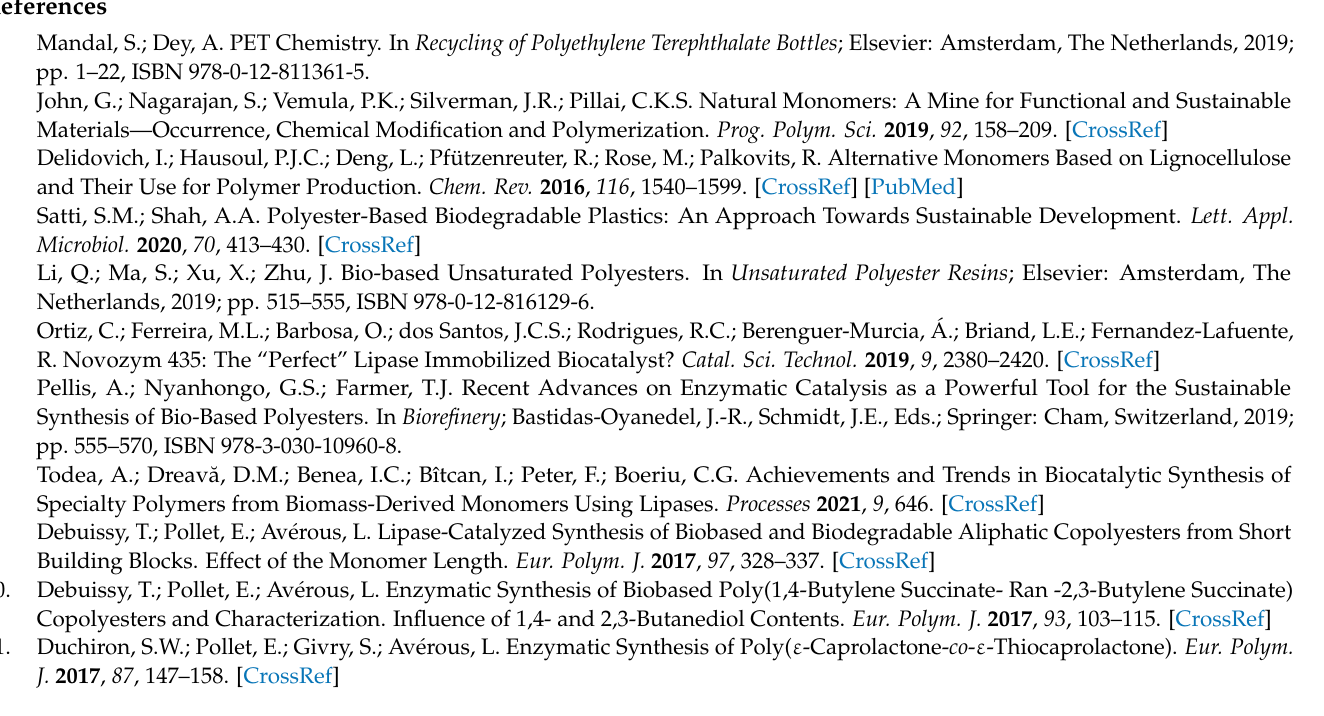
( 2b ) in CDCl 3 ; Figure S16. HSQC NMR analysis of methyl 4-(methyl butanoate-oxy)-ferulate ( 2b ) in CDCl 3 ; Figure S17. 1 H NMR analysis of poly(butylene-co-4-(methyl ethanoate-oxy)-ferulate) ( 3a ); Figure S18. 1 H NMR analysis of poly(butylene-co-4-(methyl butanoate-oxy)-ferulate) ( 3b ); Figure S19. 1 H NMR analysis of poly(butylene-co-3-(3-methoxy-4-(2-methoxy-2-oxoethoxy)phenyl) propanoate) ( 5a ); Figure S20. 1 H NMR analysis of poly(butylene-co-4-(2-methoxy-4-(3-methoxy- 3-oxopropyl)phenoxy) butanoate) ( 5b ); Figure S21. 1 H NMR analysis of poly(4-(hydroxyethoxy)- coniferylene -co-adipate) ( 7a ); Figure S22. 1 H NMR analysis of poly(4-(hydroxybutoxy)-coniferylene- co-adipate) ( 7b ); Figure S23. SEC analyses in THF of the ferulic diester-based polyesters 3a and 3b (curves were normalised by their area); Figure S24. SEC analyses in THF of the hydrogenated ferulic diester-based polyesters 5a and 5b (curves were normalised by their area); Figure S25. SEC analyses in THF of ferulic diol-based polyesters 7a and 7b (curves were normalised by their area); Figure S26. MALDI-TOF MS analysis of 7a obtained with 1.1 equivalent of diol in comparison to the diester after 24 h of synthesis in acetophenone at 90 ◦ C and under reduced pressure; Table S1. Mass of the corresponding end-groups in MALDI-TOF MS analysis of 7a obtained with 1.1 equivalent of diol in comparison to the diester after 24 h of synthesis in acetophenone at 90 ◦ C and under reduced pressure; Figure S27. SEC analyses in THF of ferulic diol-based polyesters 7a synthesized with and without an excess of diol (curves were normalised by their area); Table S2. Average molar mass and dispersity from the SEC analyses in THF of ferulic diol-based polyesters 7a synthesized with and without an excess of